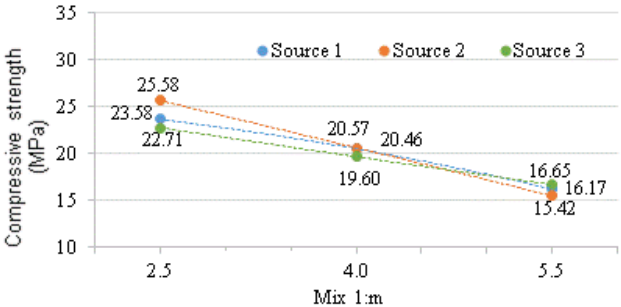
Figure 11. Effect of the mix-source interaction in axial compressive